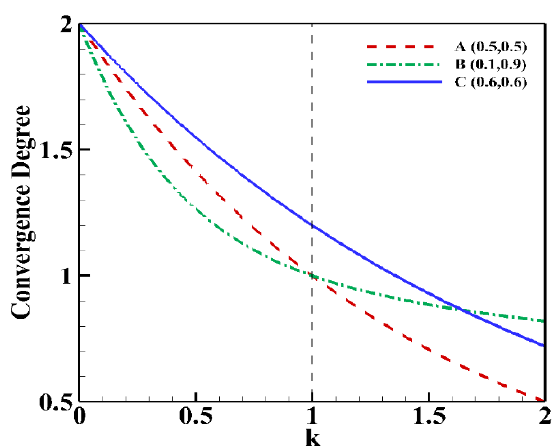
Figure 1. Convergence degree of solutions A(0.5, 0.5), B(0.1, 0.9) and C(0.6, 0.6) with variation in parameter 𝑘 ∈ [0,2] , [24].